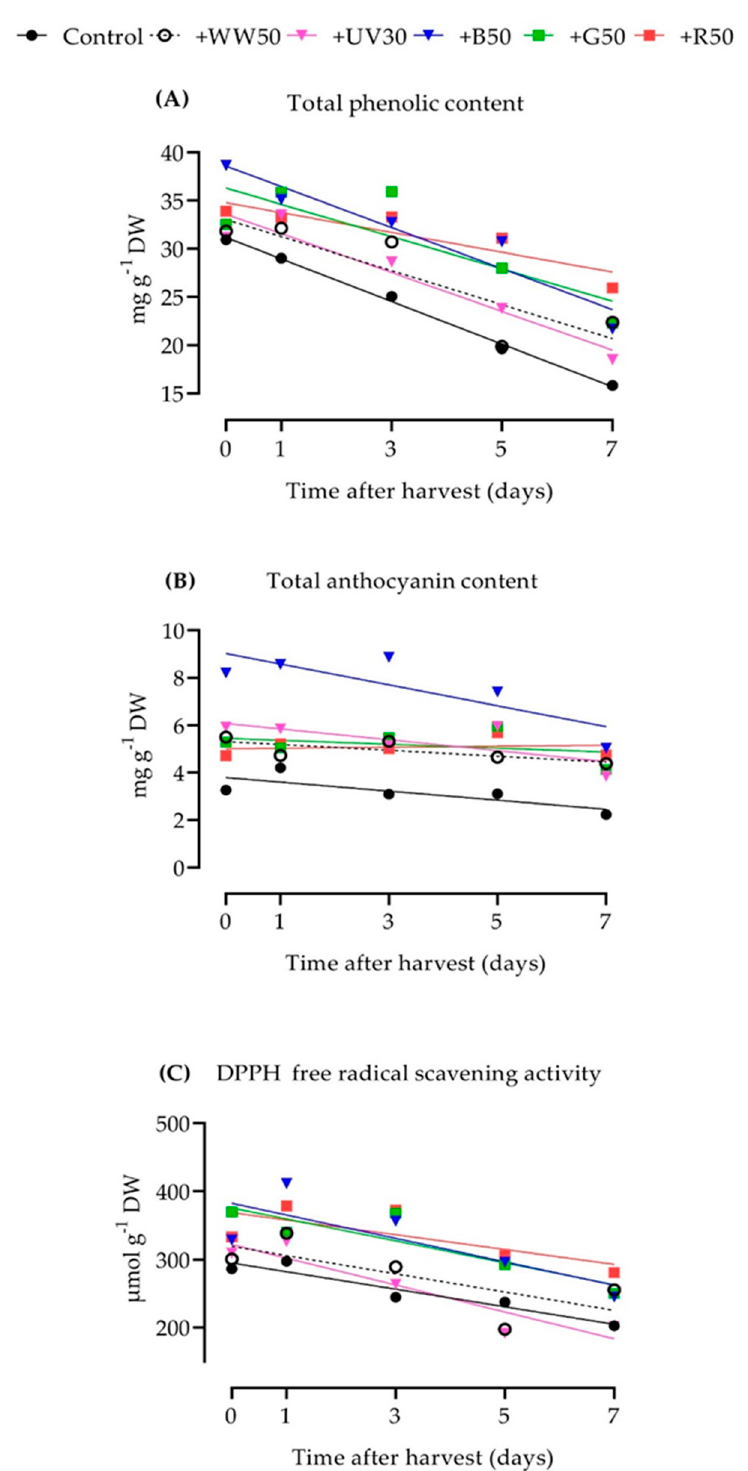
Figure 2. Concentrations of total phenolic content ( A ), total anthocyanin content ( B ), and DPPH free radical scavenging activity (C) in ‘Rouxai’ baby-leaf lettuce from harvest until 7 d after harvest. See Table 2 for a description of treatments. Data are presented as the mean of two replications with three randomly selected plants and three analytical measurements per sample ( n = 6 ). Linear regression was performed for each treatment and compound.